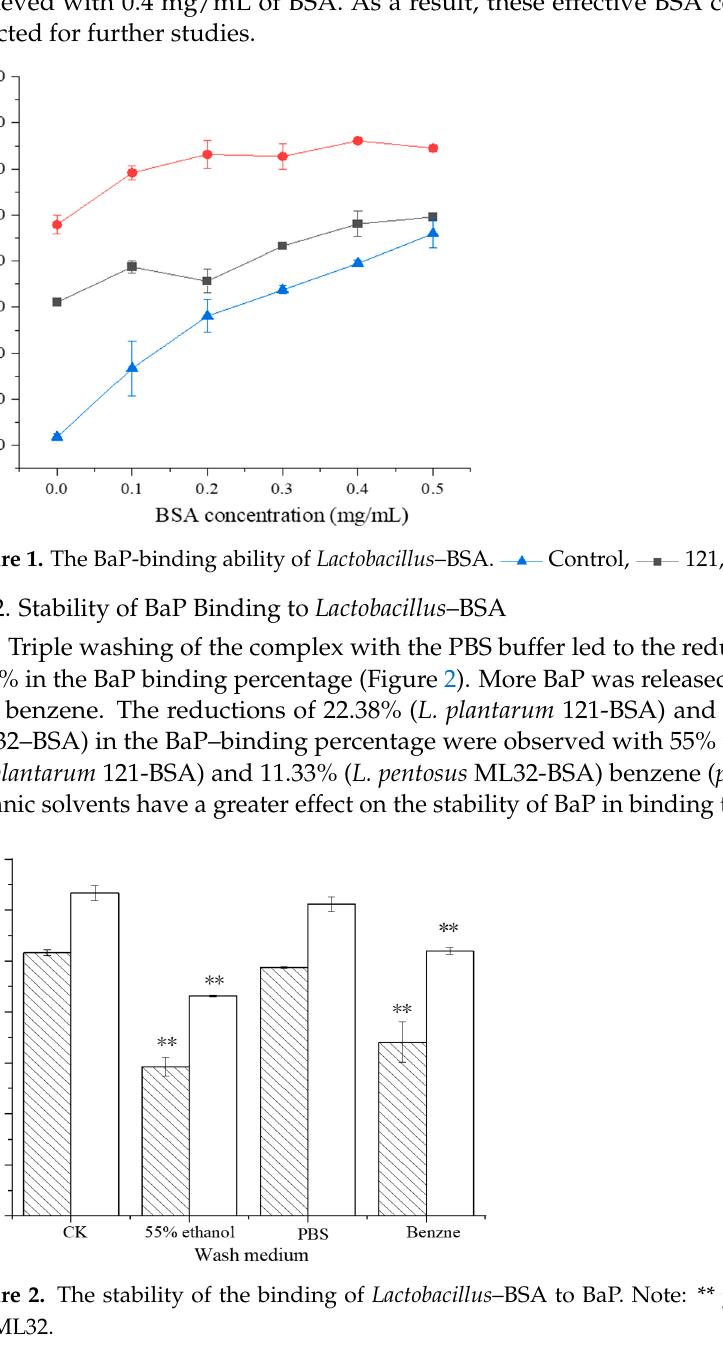
to BaP. Note: ** p < 0.01. 121 and